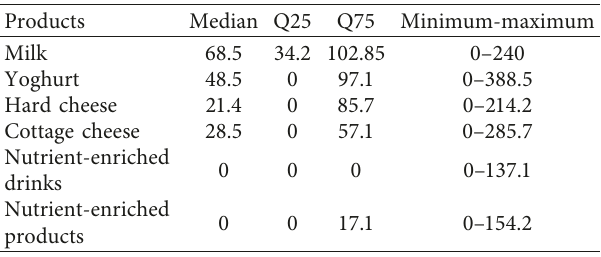
Table 2: The examined group’s Ca intake (mg/day) obtained from food products.